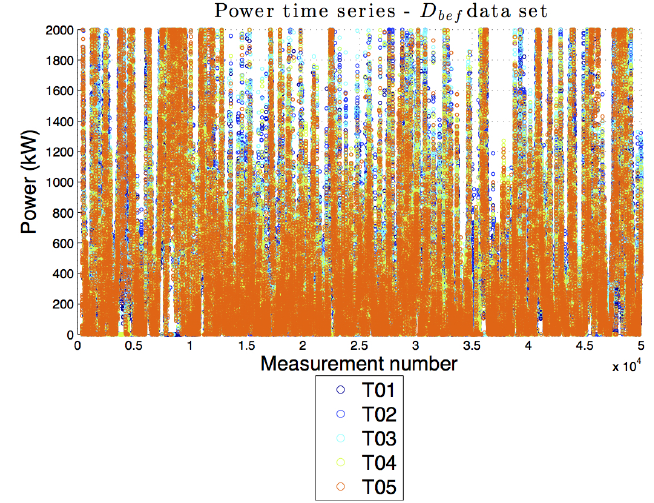
Figure 2. The power time series: D bef data set.